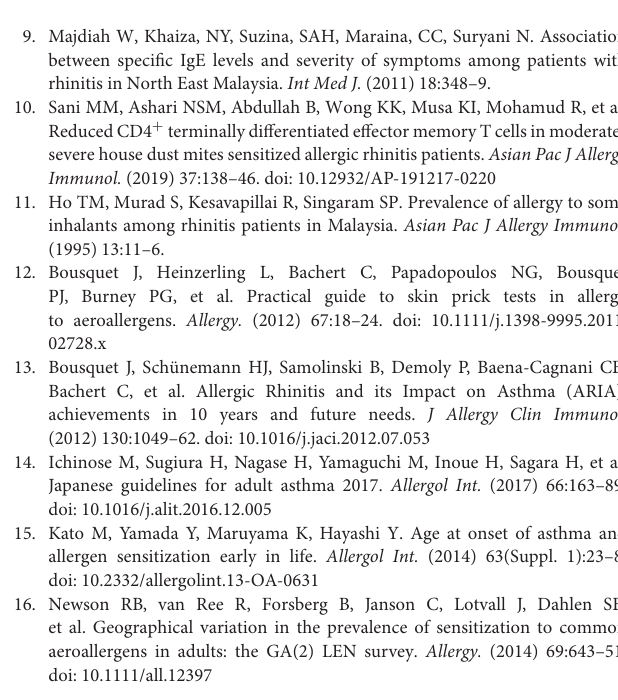
Supplementary Figure 1 | Association of nasal symptoms severity scores with the number of HDM allergens sensitization of AR patients. Supplementary Figure 2 | Association of non-nasal symptoms severity scores with number of HDM allergens sensitization of AR patients. Supplementary Table 1 | The 7-point visual analog scale (VAS) indicator to assess AR nasal and non-nasal symptoms severity